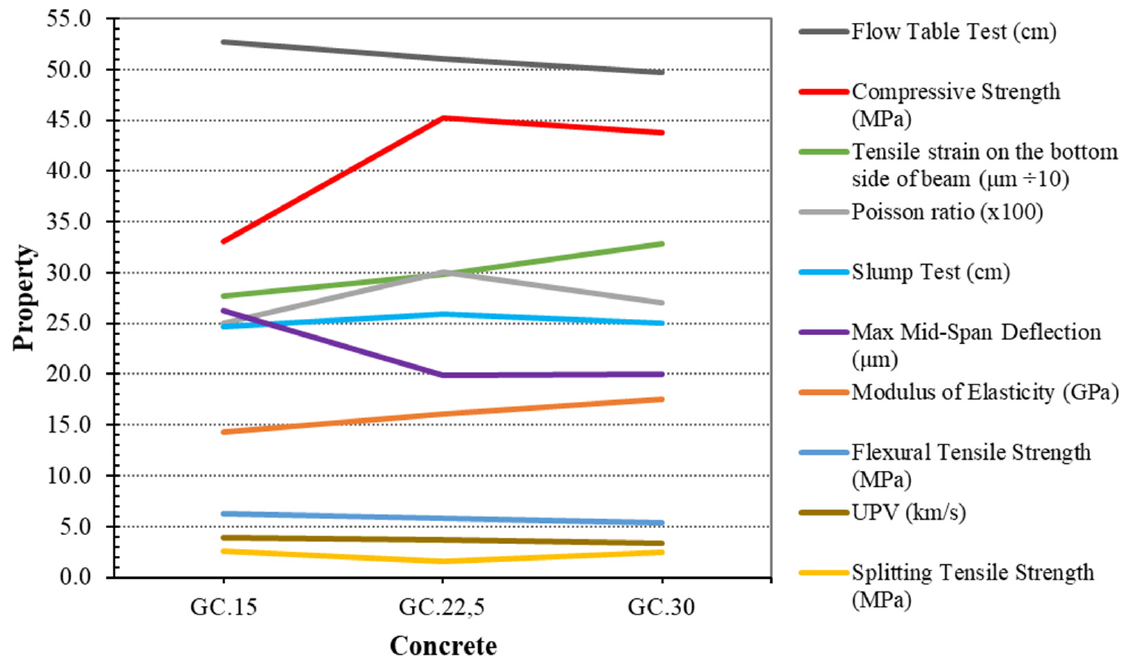
Figure 12. Comparison of the properties of all GC mixtures.